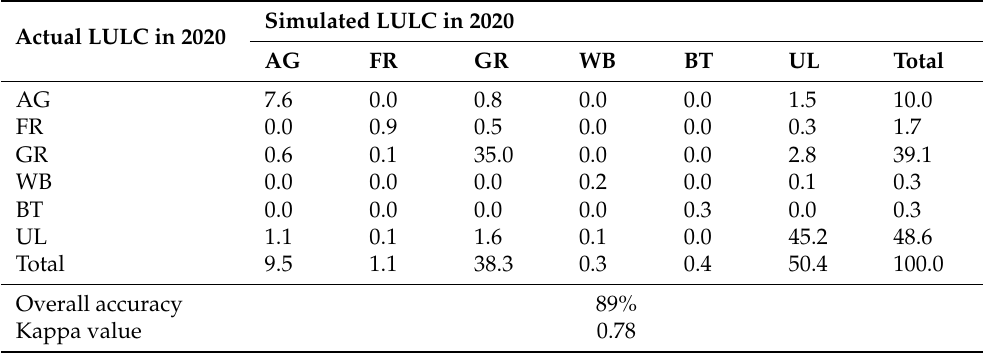
Table 4. Contingency table of simulated and actual LULC in 2020